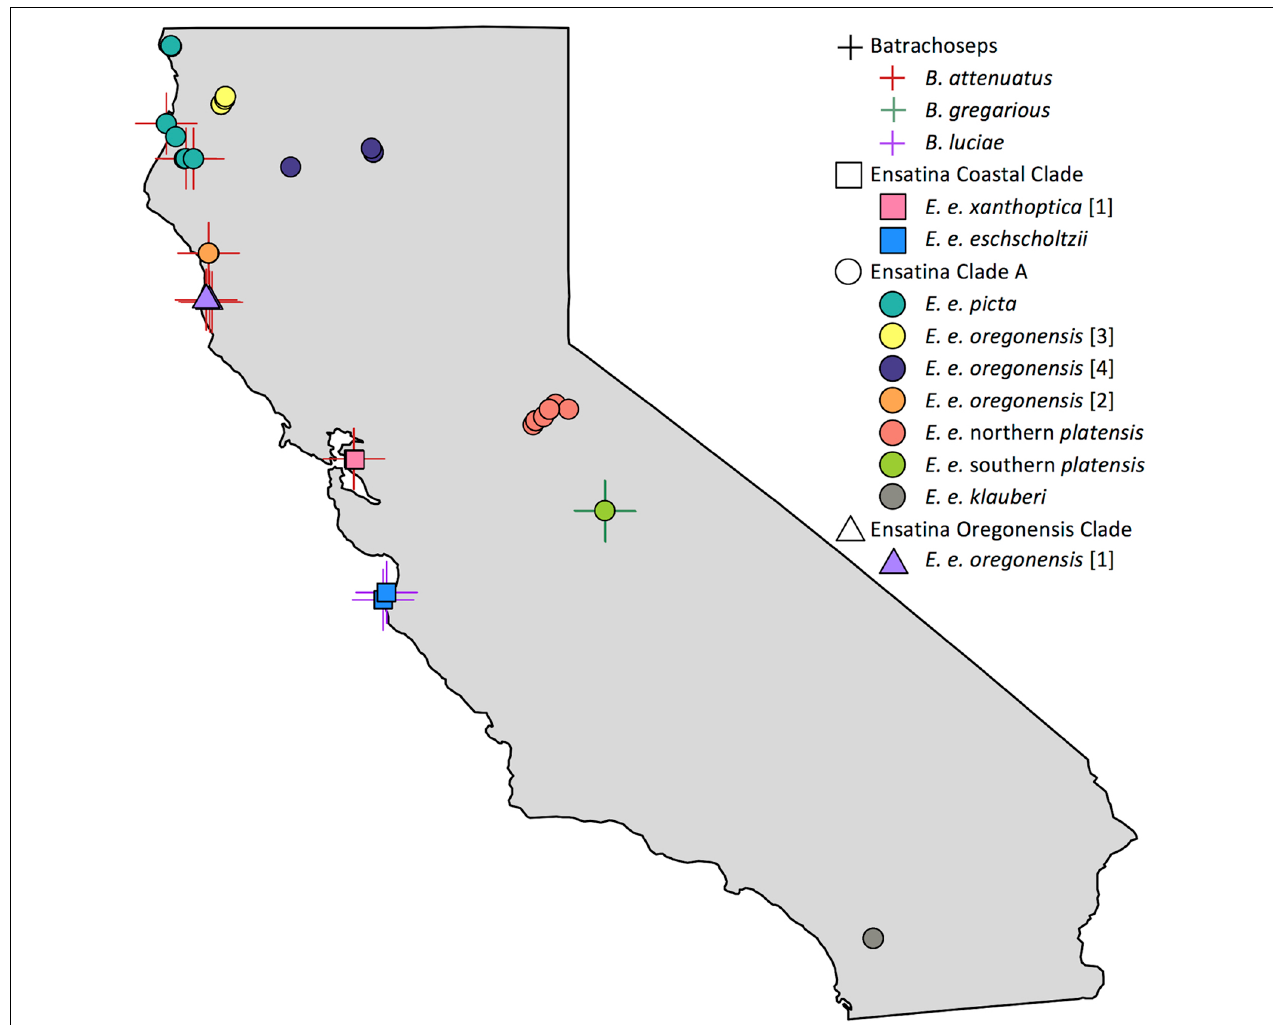
FIGURE 1 | Map of Batrachoseps and Ensatina sampling localities within California. Batrachoseps samples represented with a cross symbol, species distinguished by color. Ensatina higher clade groups differentiated by shape (Coastal Clade, square; Clade A, circle; Oregonensis Clade, triangle), lower clade groups distinguished by color. Some symbols overlap due to close proximity of samples. Note that samples from lower clade groups E. e. croceater and E. e. xanthoptica [2] were not collected in this study. This figure created in R (Becker and Wilks, 2016; R Core Team,